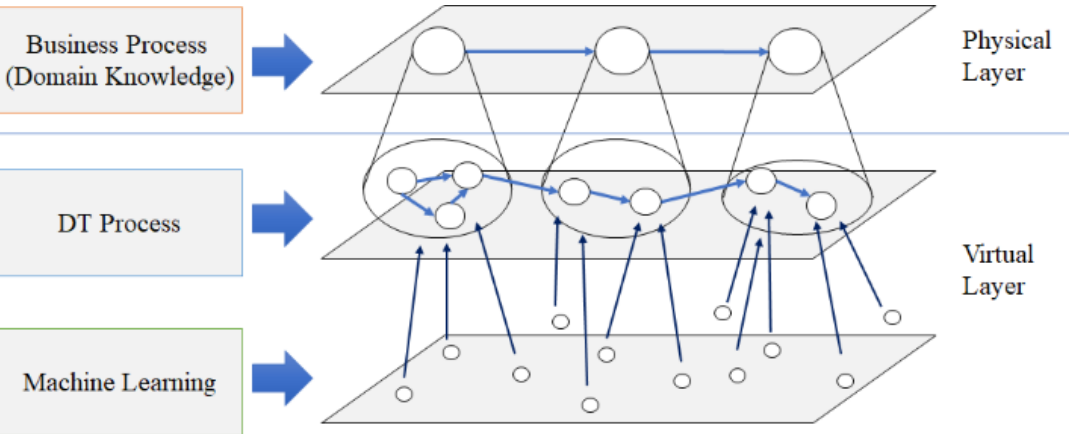
Figure 2. Virtual model concept.